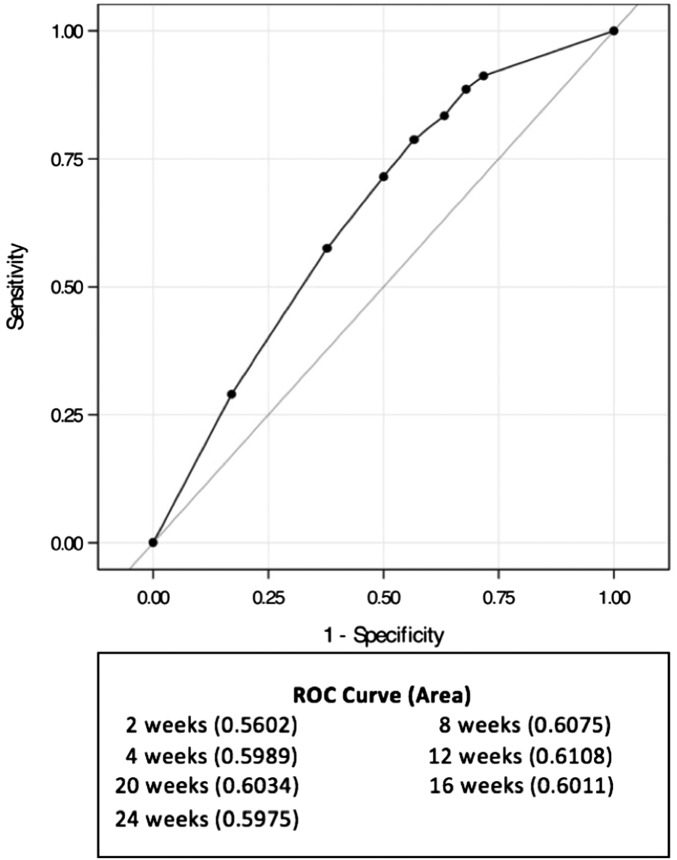
Cut-off intervals to discriminate CD reinfection from relapse. Each cut-off is used to predict reinfections. The areas under the ROC curve (AUC) indicate that the discriminatory power of all the cut-offs is not effective. The 12-week cut-off is associated with the highest AUC.